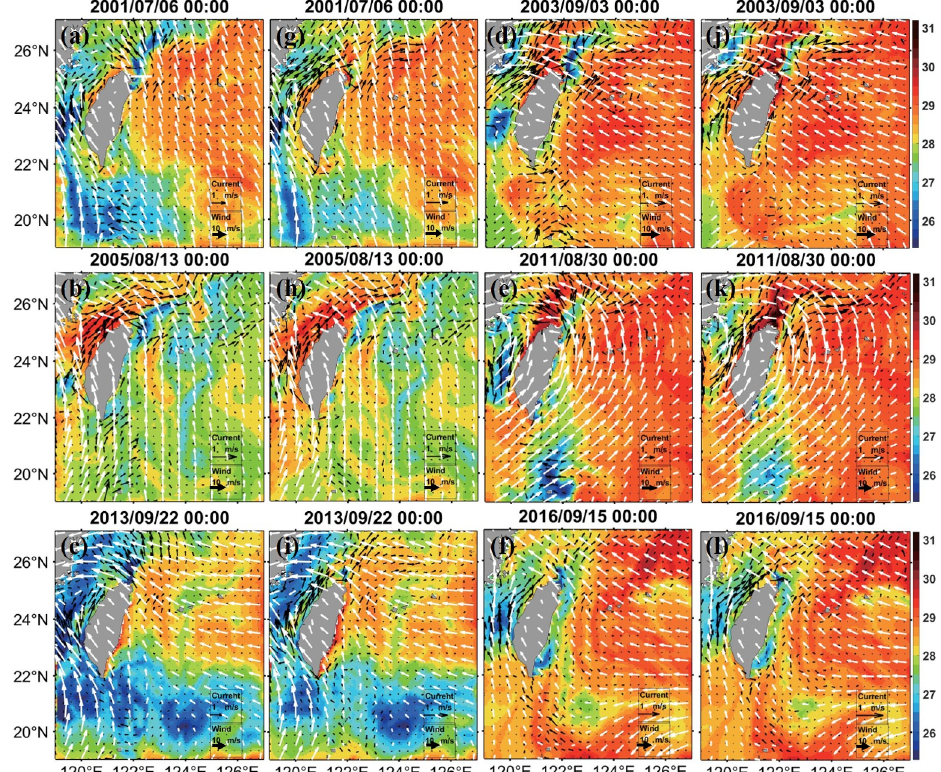
Figure 6. Depth-averaged, 42-h low-passed ocean current in black arrows and 42-h low-passed SST with tidal forcing ( left panels, a-c, g-i ). Corresponding results but retrieved from 6 simulations with- out tidal forcing during 6 typhoon passages are shown in right panels (d-f, j-l ). Additionally marked is 10-m wind in white arrows (scaled in bottom-right corners). White line in Figure 6a denotes the location of the zonal transect shown in Figure 7.